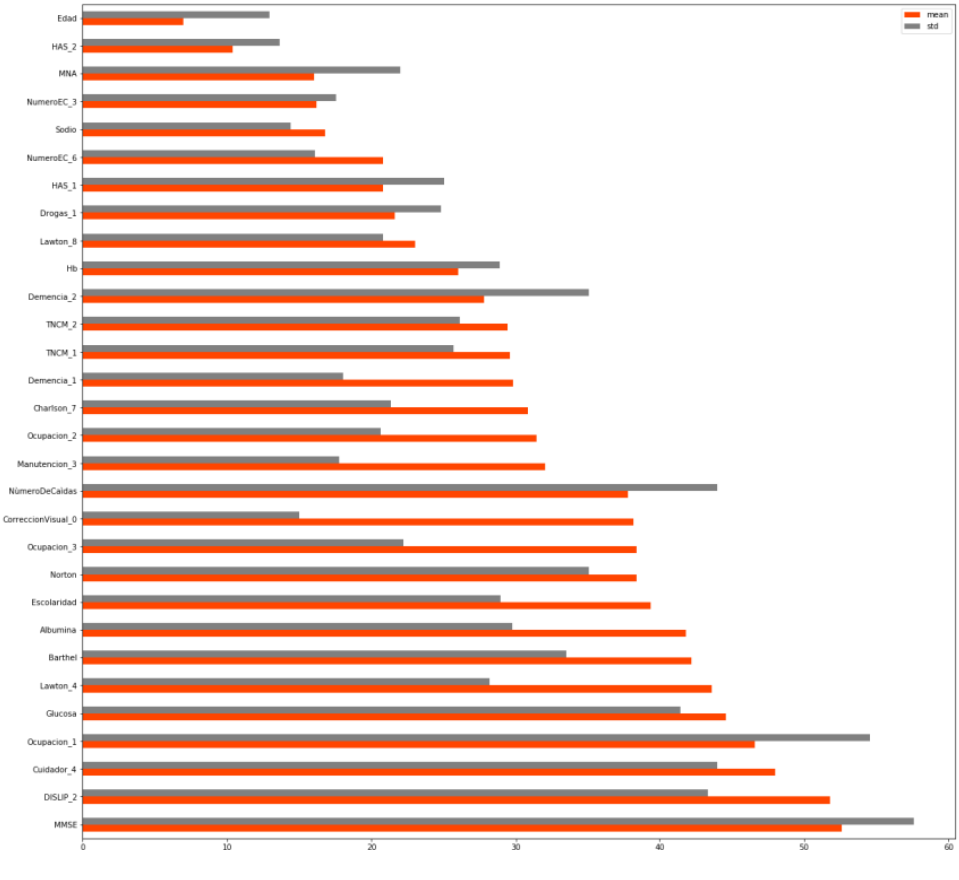
Figure 1. Variable ranking.